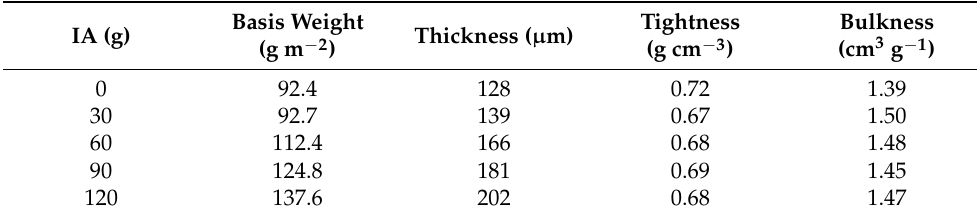
Table 1. Physical properties of the as-prepared fire-resistant paper sheets based on ultralong HAP nanowires with different addition amounts of